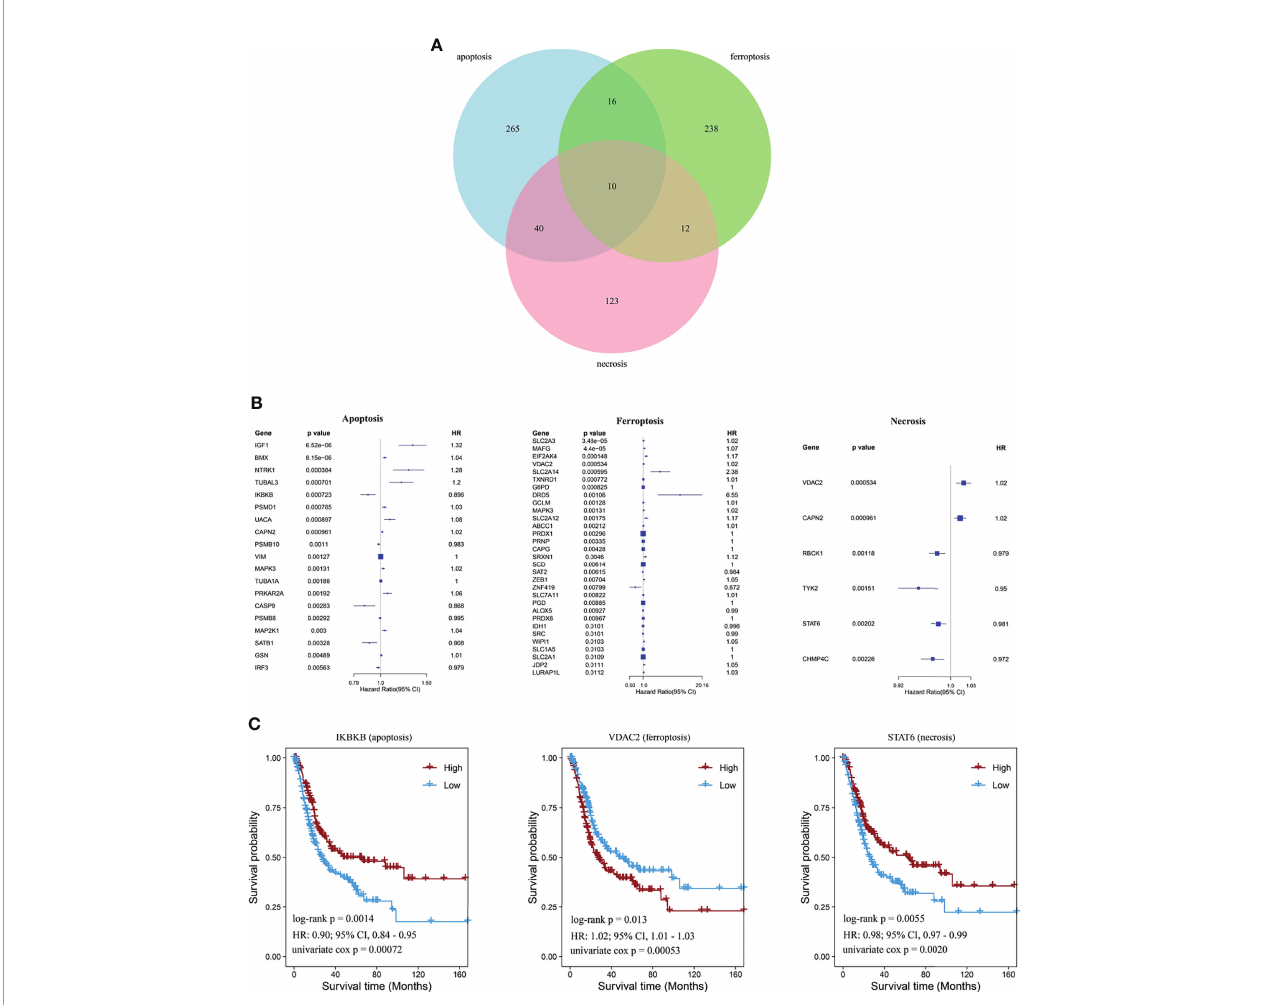
FIGURE 1 | Identi fi cation of cell-death pathway factors associated with prognostic values. (A) Venn diagram showing unique and identical genes of apoptosis, necrosis, and ferroptosis. (B) Forest plot showing signi fi cant signatures using univariate Cox regression analysis. (C) Kaplan – Meier curves showing prognostic values of IKBKB, STAT6 , and VDAC2 of